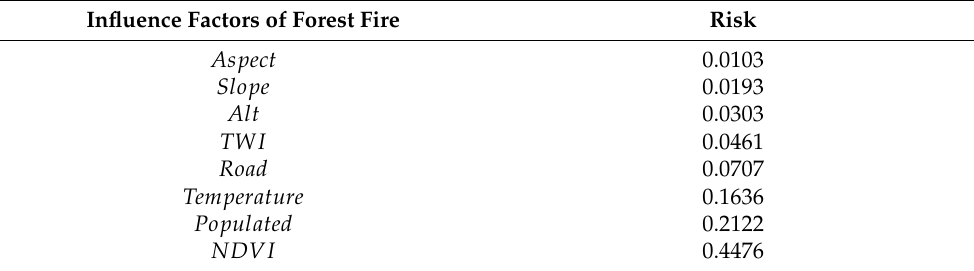
Table 12. The weight distribution result of each